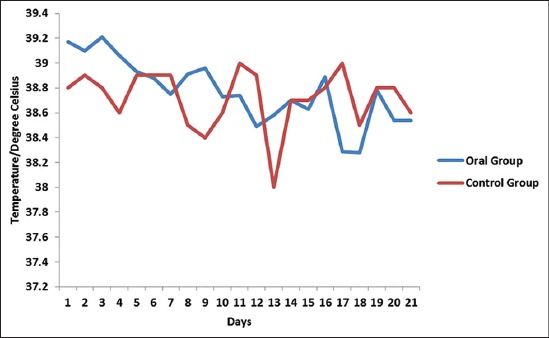
Mean rectal temperatures for the oral group after 21 days of inoculation with Pasteurella multocida Type B:2.